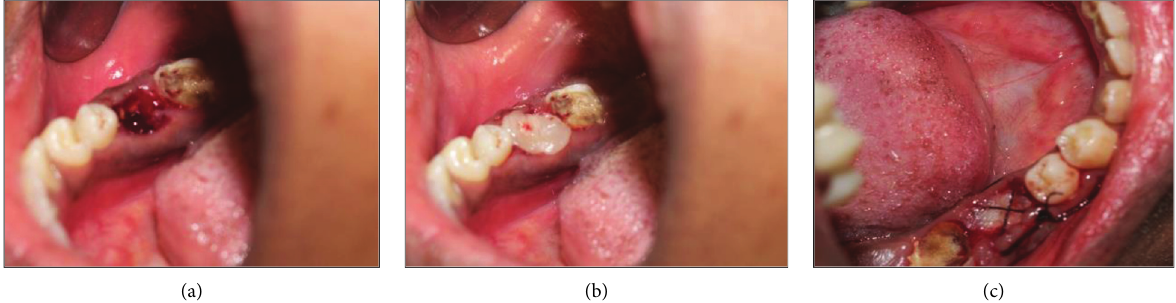
Figure 2: (a) Extraction socket. (b) PRF membrane filled in the socket. (c) Figure-eight suture